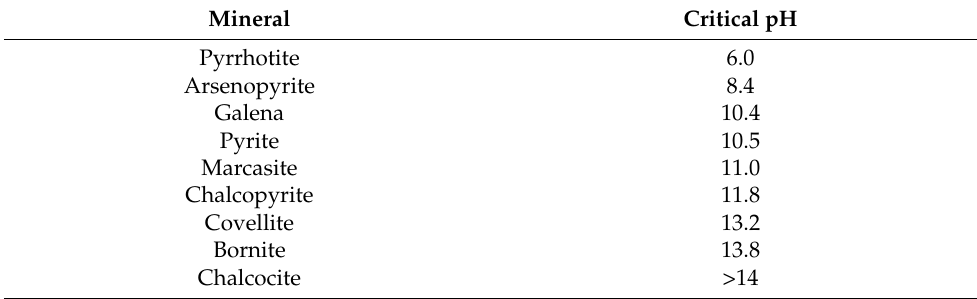
Table 3. Critical pH values of different sulfide minerals (ethyl xanthate